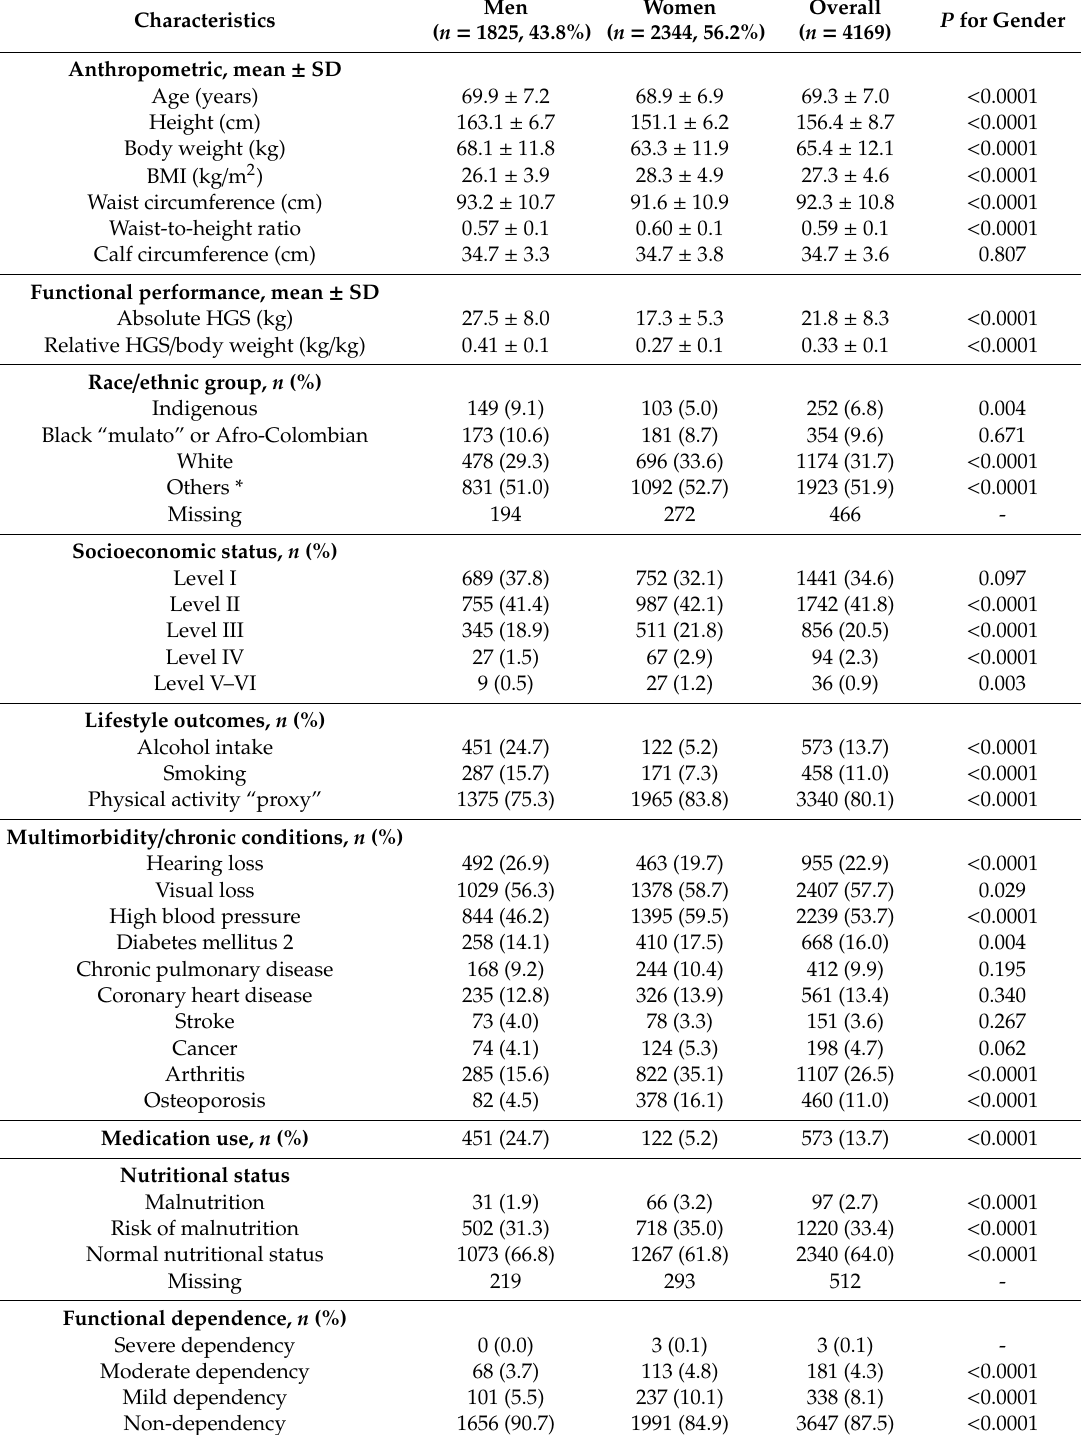
Table 1. Characteristics of the study